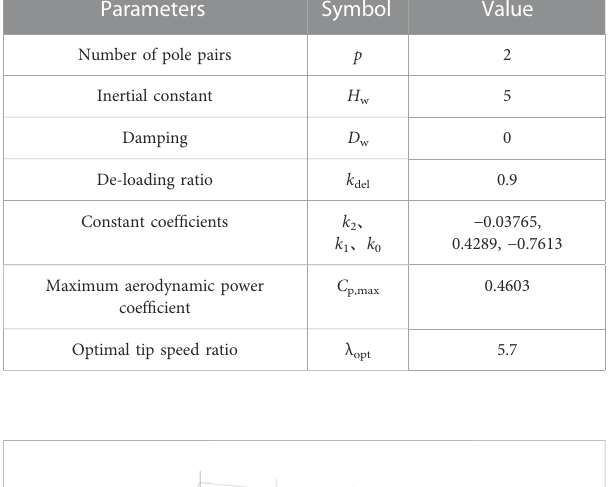
TABLE 2 Parameters of DFIG-based WT.